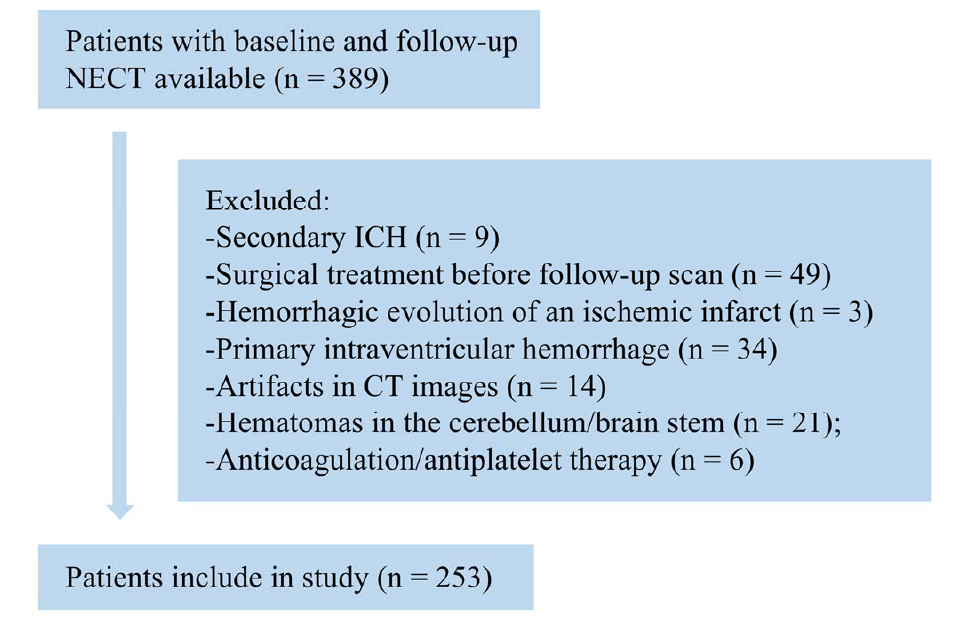
Figure 2. Criteria and statistics for the selection of retrospective